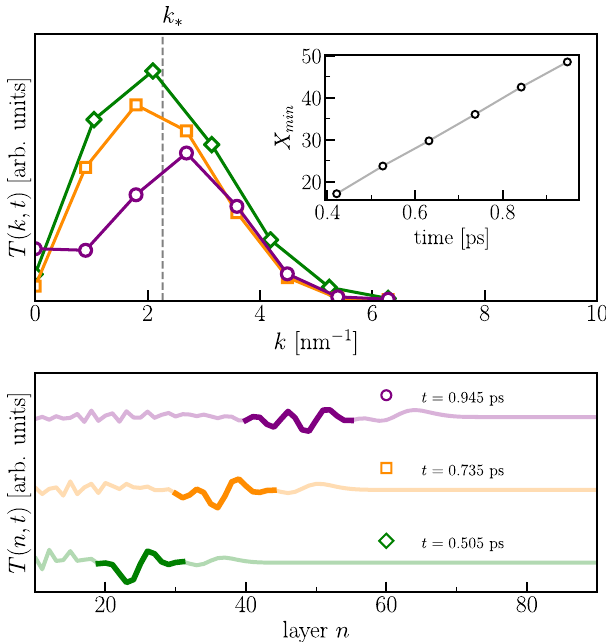
Fig. 5 Spectral analysis in k-space of the electronic temperature waves. Top panel: spatial Fourier transform of the layer pro fi le of the electronic temperature at three different times, t = 0.505ps (diamonds), t = 0.735 ps (squares) and t = 0.945ps (circles). The inset shows the position of the minimum of the temperature oscillation, indicated in the bottom panel, as a function of time. The vertical dashed line indicated by k * shows the average of the position of the three peaks. Bottom panel: Portions of the temperature pro fi les at different times used to compute the discrete Fourier transform. The arrows indicate the positions X min and X max .